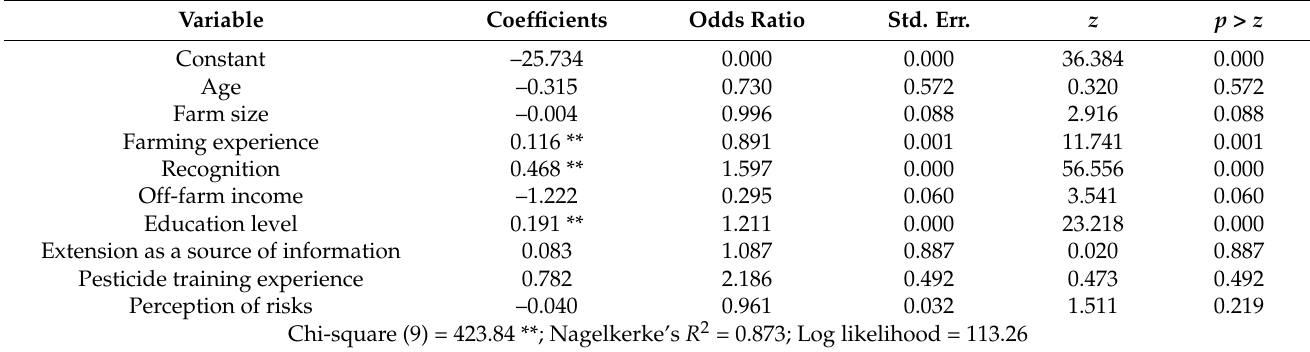
Table 8. Factors influencing the purchasing of fraudulent